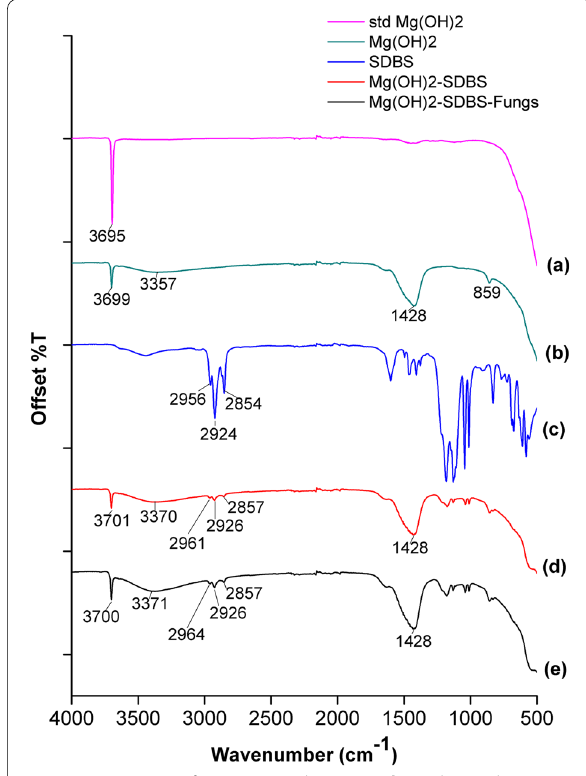
Fig. 6 FTIR spectra of a commercial Mg(OH) 2 , b synthesized